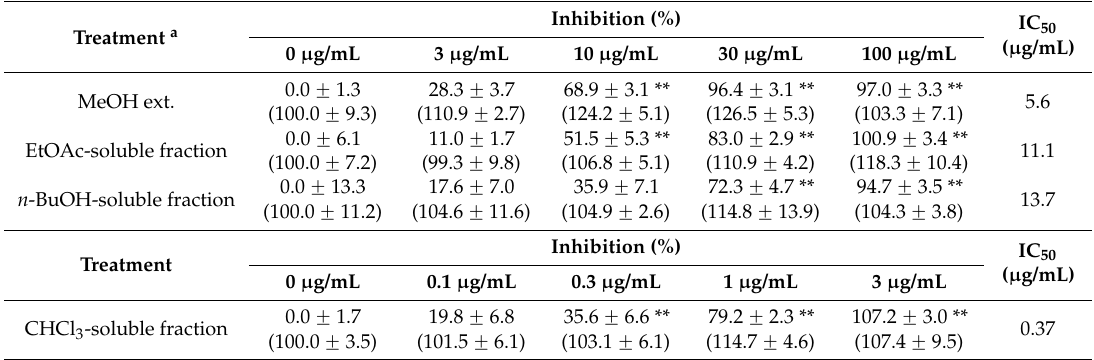
Table 1. Inhibitory effects of the methanol extract and its fractions from lotus flower on theophylline-stimulated melanogenesis and viability in B16 4A5